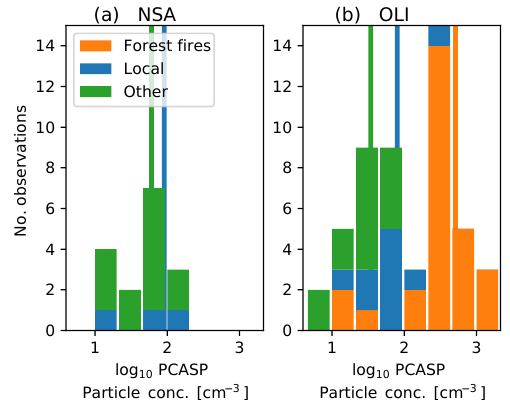
Figure 12. Stacked histograms of PCASP particle concentration for (a) NSA and (b) OLI for clouds classified as forest fire (orange), local (blue), and the residual (green). The vertical lines are for the corresponding linear mean